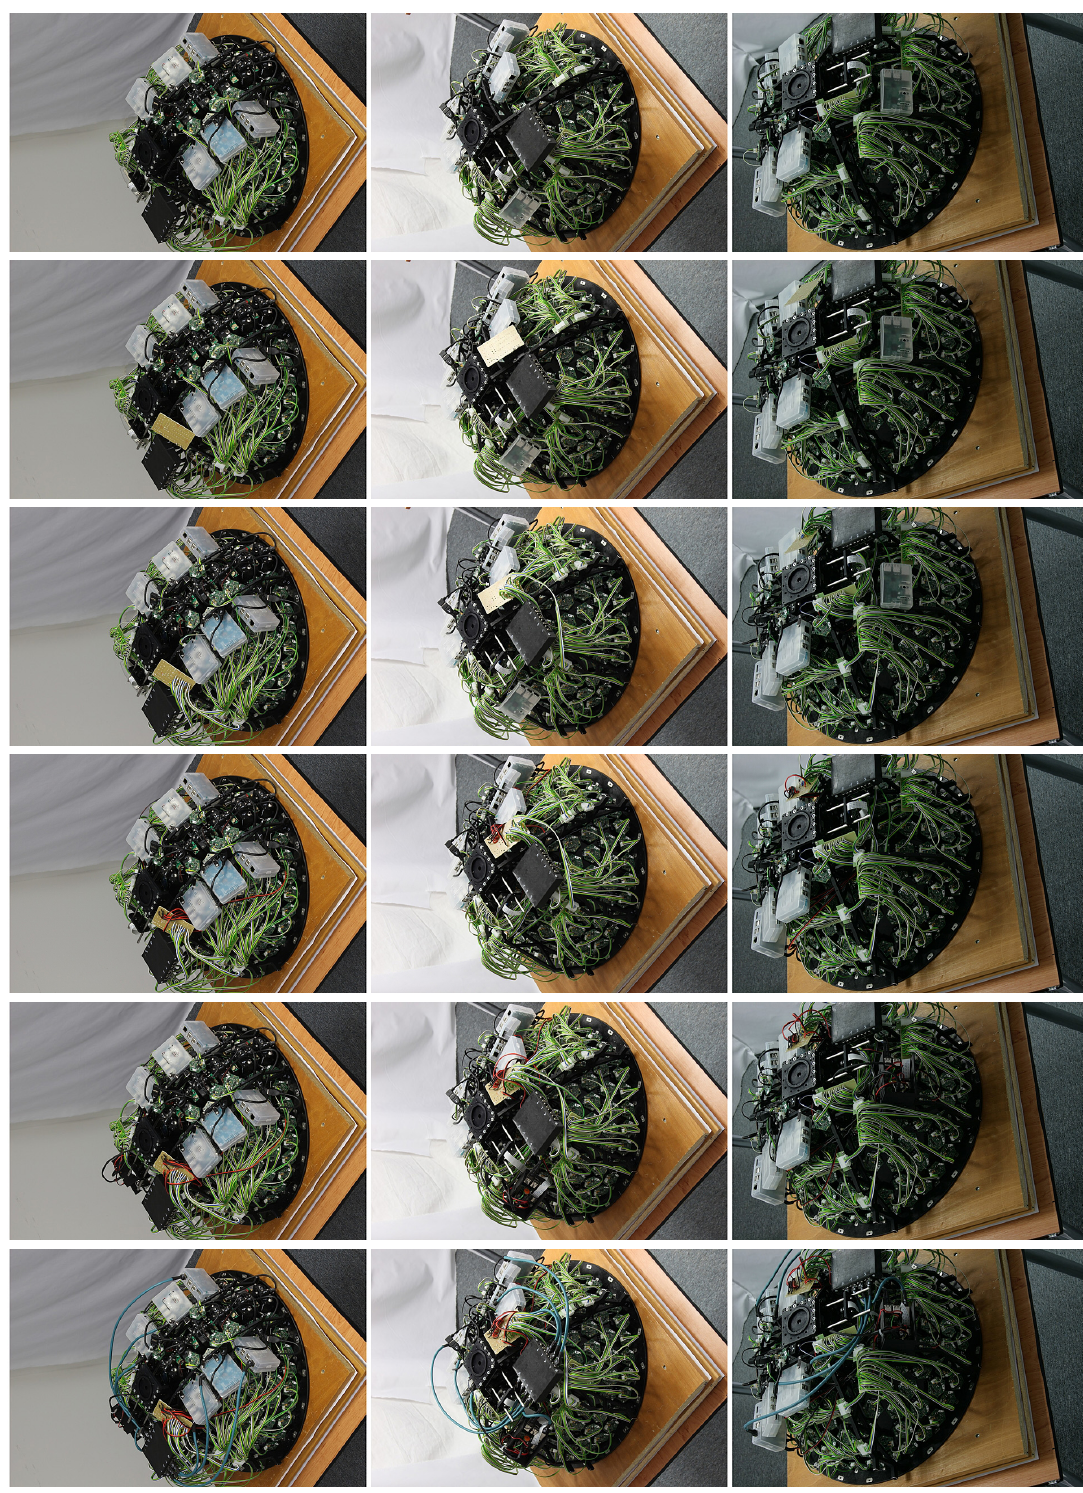
Figure A3. Assembly of lightdrum, step 13 to 18 from three different views. Row 1: mounting the gigabit Ethernet switch and connecting cameras with microcomputers by USB 3.0 cables; Row 2: adding the main RS485 distribution board; Row 3: connecting eight distribution boards to the main one; Row 4: connecting six microcomputers to the power; Row 5: changing the Raspberry Pi 2 cover, adding electronics and connecting stepper motor, laser module and camera for auto-collimator; Row 6: connecting six embedded microcomputers to gigabit Ethernet